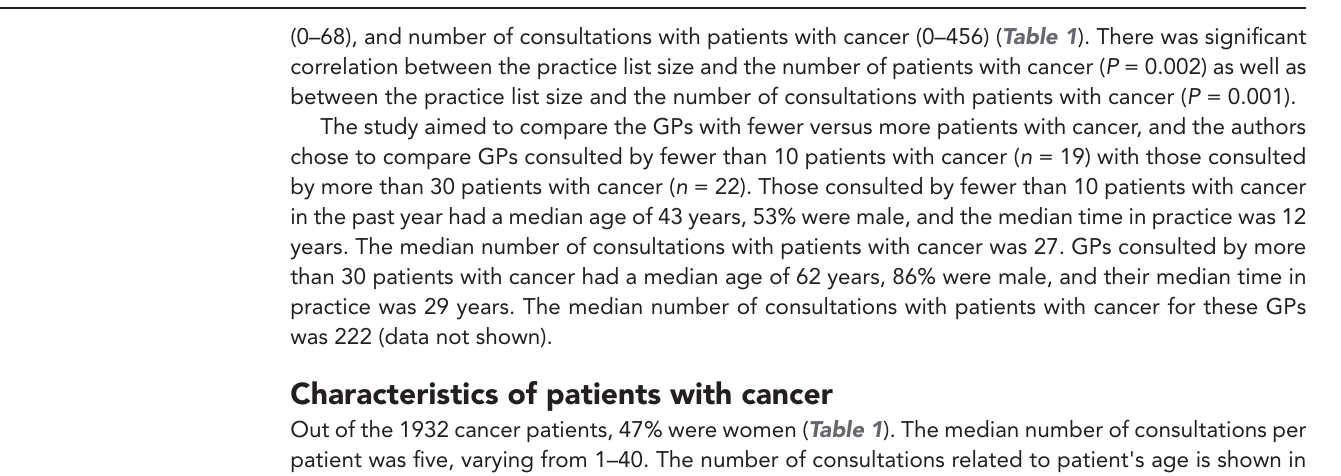
Figure 1 Consultations by age of patient with cancer in a 1-year study. Consultations: n = 11 074. Patients with cancer: n = 193. Sample: n = 1931 (missing data: n =